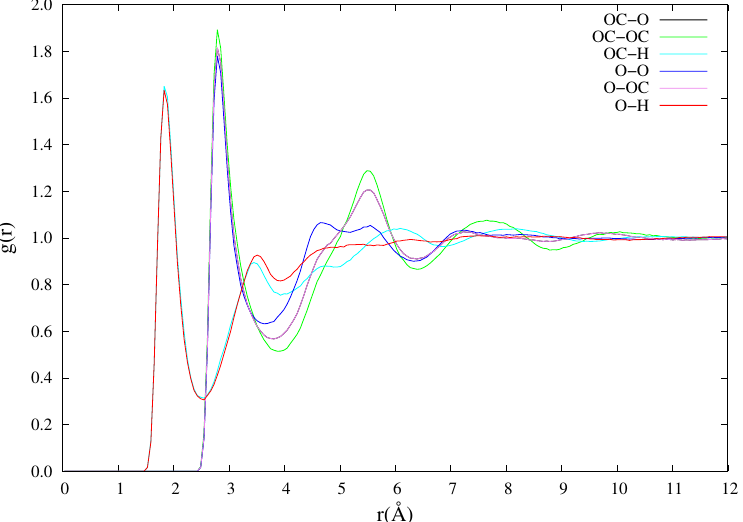
Figure 2. Radial distribution function of glycerol at 298K and equilibrium density 1.259g/cm 3